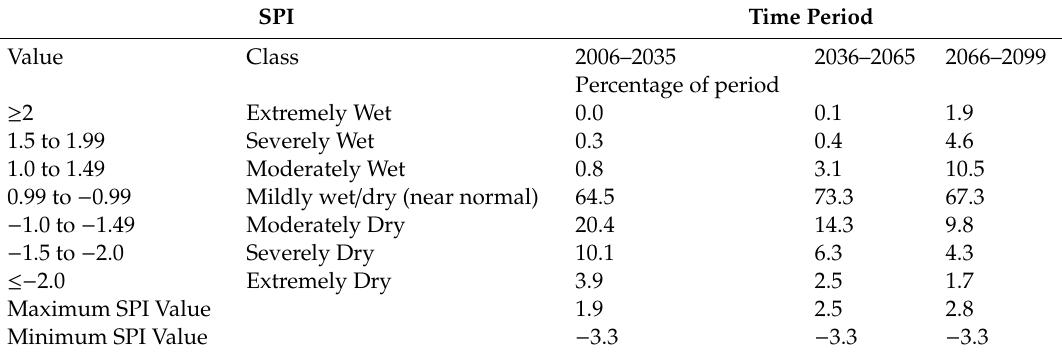
Table 11. Percentage variation of SPI values for Gulu over the period